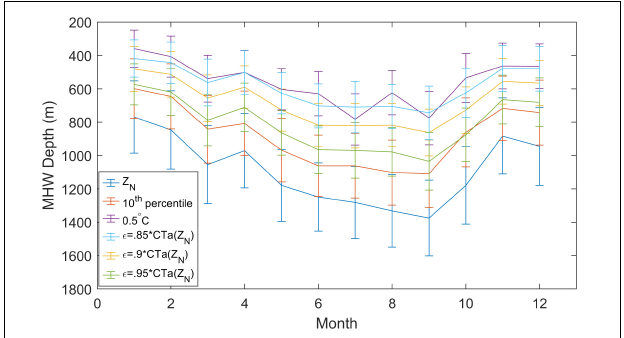
FIGURE 4 | Sensitivity analysis: Mean MHW depth per month used as a dependent variable for testing the effect of different MHW depth cut-off methods. Positive Threshold Depth, 10th percentile (the value below which 10% of the observations are found), absolute value of temperature anomaly at 0.5 ◦ C and the CTa cut-off with ε = 0.95,0.9,0.85. Bars represent the standard errors.